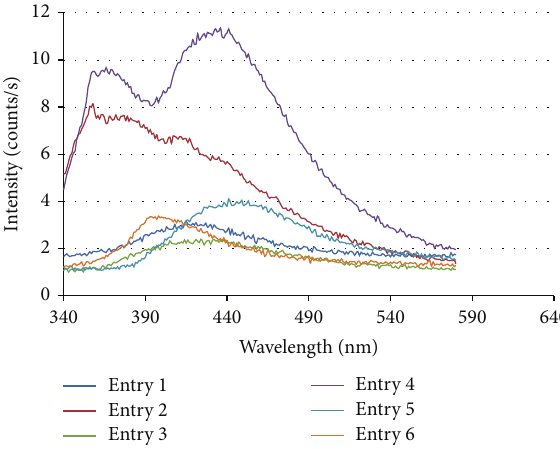
Figure 5: Fluorescence spectrum of ZnO